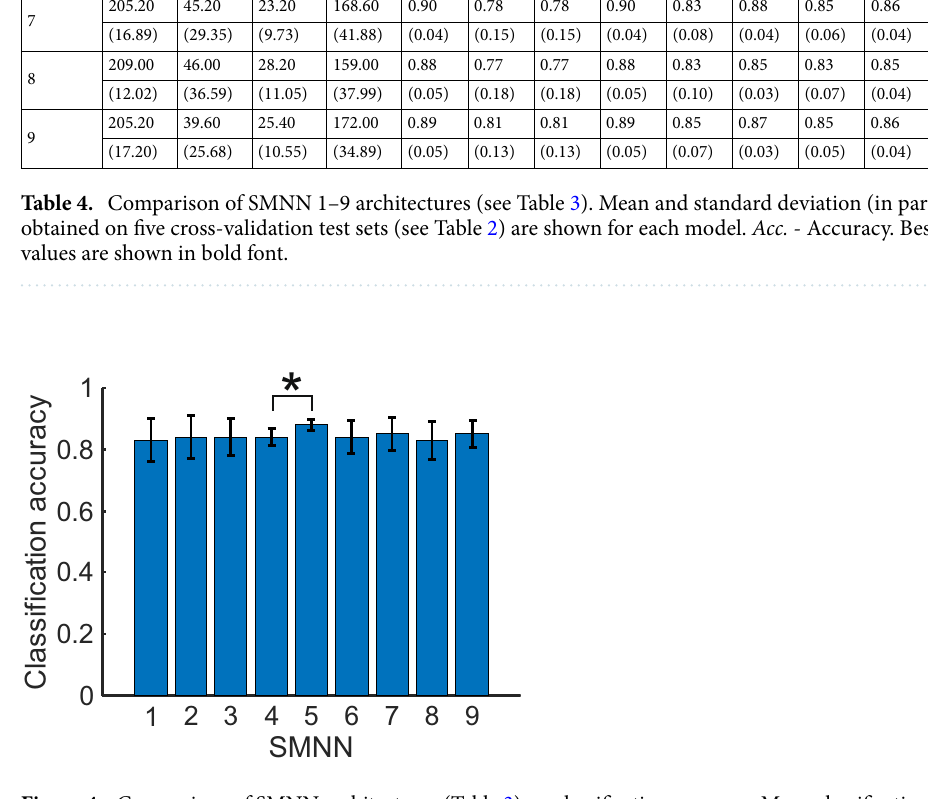
Figure 4. Comparison of SMNN architectures (Table 3) on classification accuracy. Mean classification accuracy obtained on five cross-validation test sets (Table 2) are shown for each model. Error bars denote confidence intervals of mean (95%). Mean difference of SMMN 5 and SMMN 4 is statistically significant ( t − test , p = 0.0381 ). Differences of all other means are not statistically significant ( t − test , p > 0.05 for all other